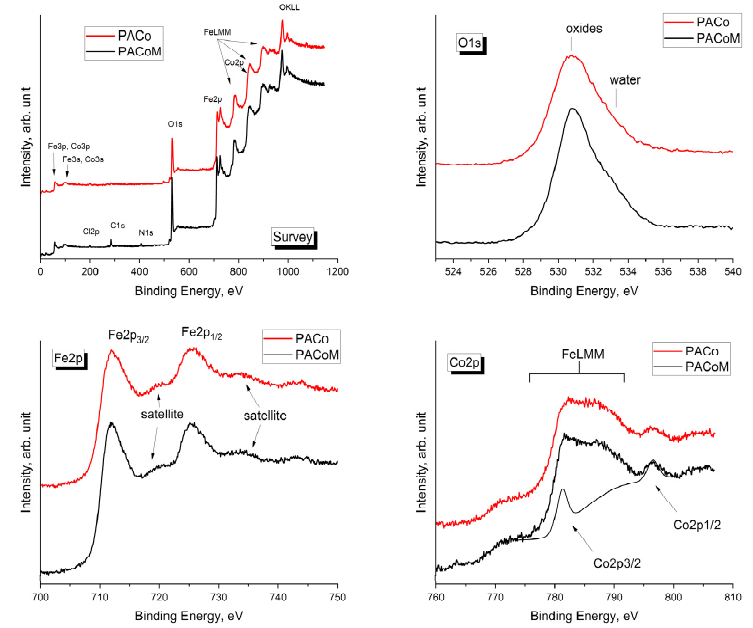
Figure 3. Comparison of the survey, Fe2p, Co2p, and O1s spectra for the PACo and PACoM samples. Table 2. Binding energy (BE) value and XPS quantification (at. %) for the PACo and PaCoM samples. Sample